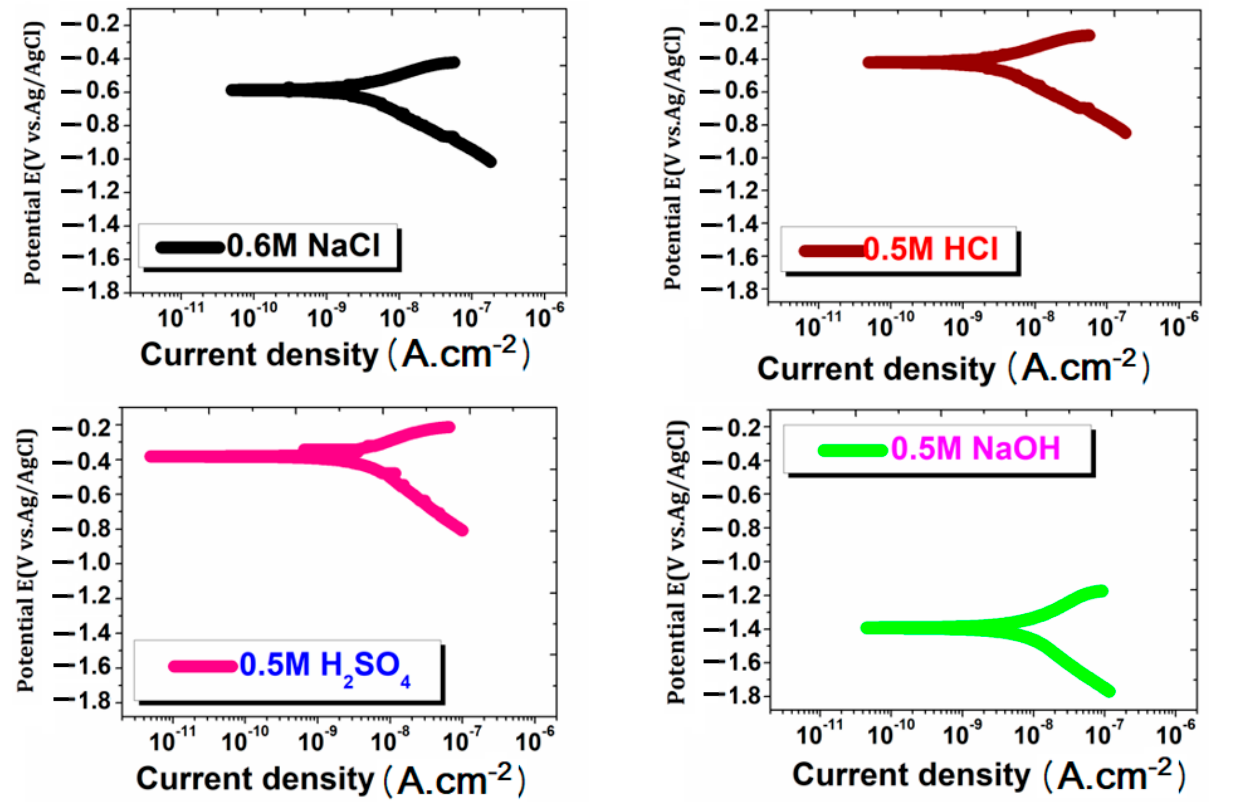
Figure 4. PDP plots of 17.5%B 4 C/Al-Mg-Si AMCs obtained in various